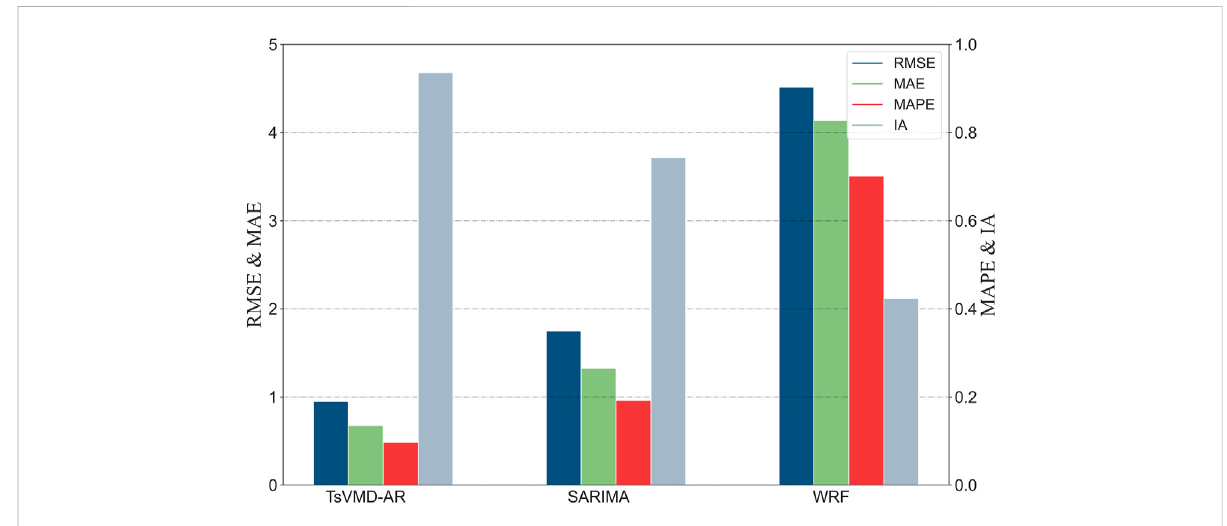
FIGURE 4 Evaluation criteria results of different forecasting models for period 1.